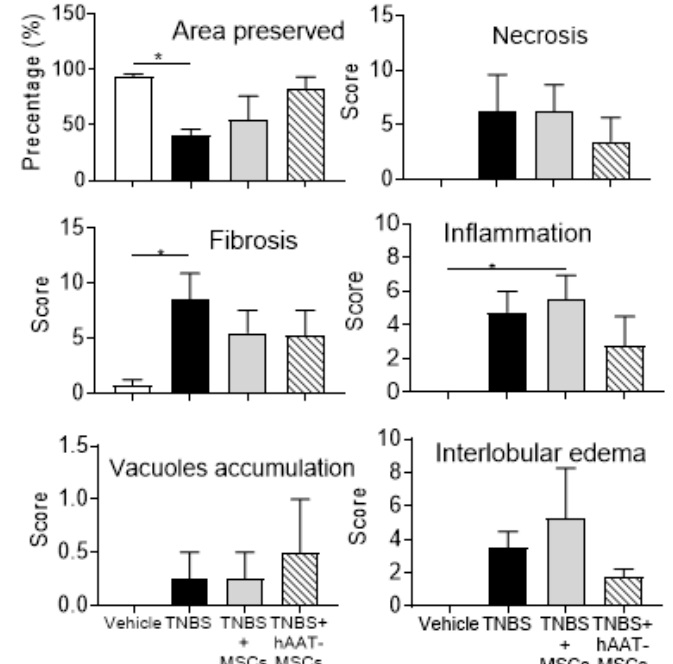
Figure 2. Human alpha-1 antitrypsin-overexpressed mesenchymal stromal cells (hAAT-MSC) and MSC infusions improve pancreas morphology of chronic pancreatitis (CP) mice 4 weeks post trini- trobenzene sulfonic acid (TNBS) treatment. To assess whether MSCs have any protective effects on pancreas damage, pancreas tissues were stained with Hematoxylin and Eosin (H&E) and Masson Trichrome. ( A ) Pancreatic structure of hAAT-MSC or native MSC-treated TNBS mice were better preserved and showed significantly reduced staining of collagen and more normal histology. ( B ) The stained pancreatic sections were scored by a pathologist according to six categories ( n = 4 mice in each group). Increased fibrosis and inflammation were seen in the pancreas of TNBS-treated mice compared to that of the vehicle, while the pancreas in those treated with native MSCs or hAAT-MSCs displayed better morphology. This data further confirmed the protective effects of MSCs on TNBS- induced pancreas damage. Scale bar = 2 mm. Data presented are mean ± SEM. One-way ANOVA and Tukey’s test were used. * p <